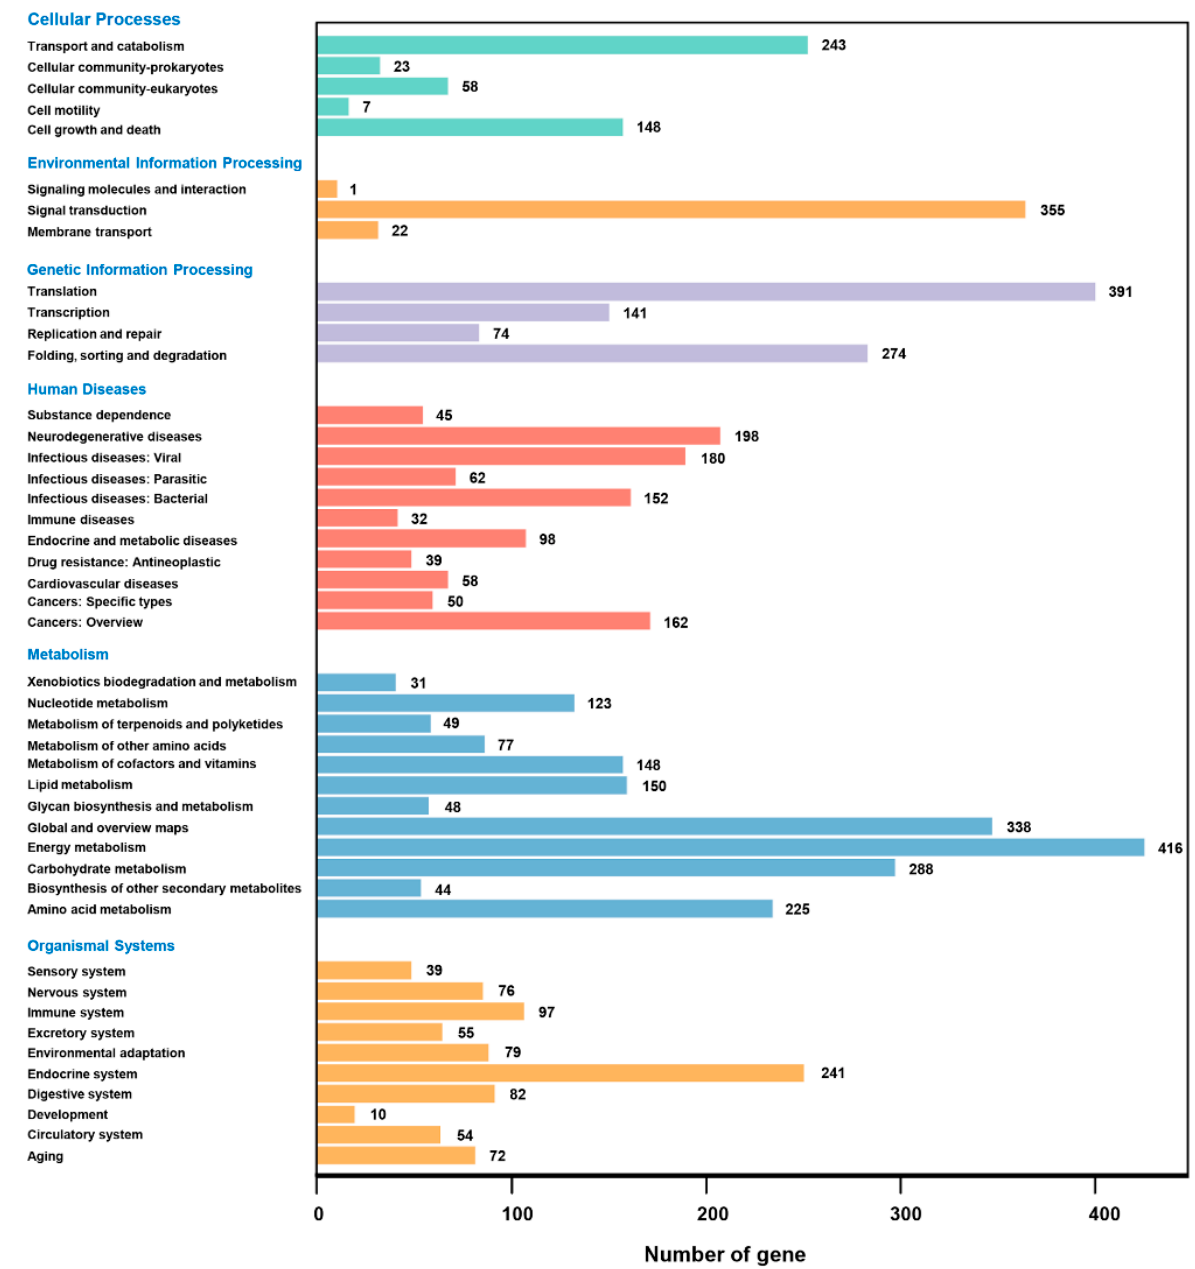
Figure 3. Kyoto Encyclopedia of Genes and Genomes classification of all the unigenes of Heterosigma akashiwo .